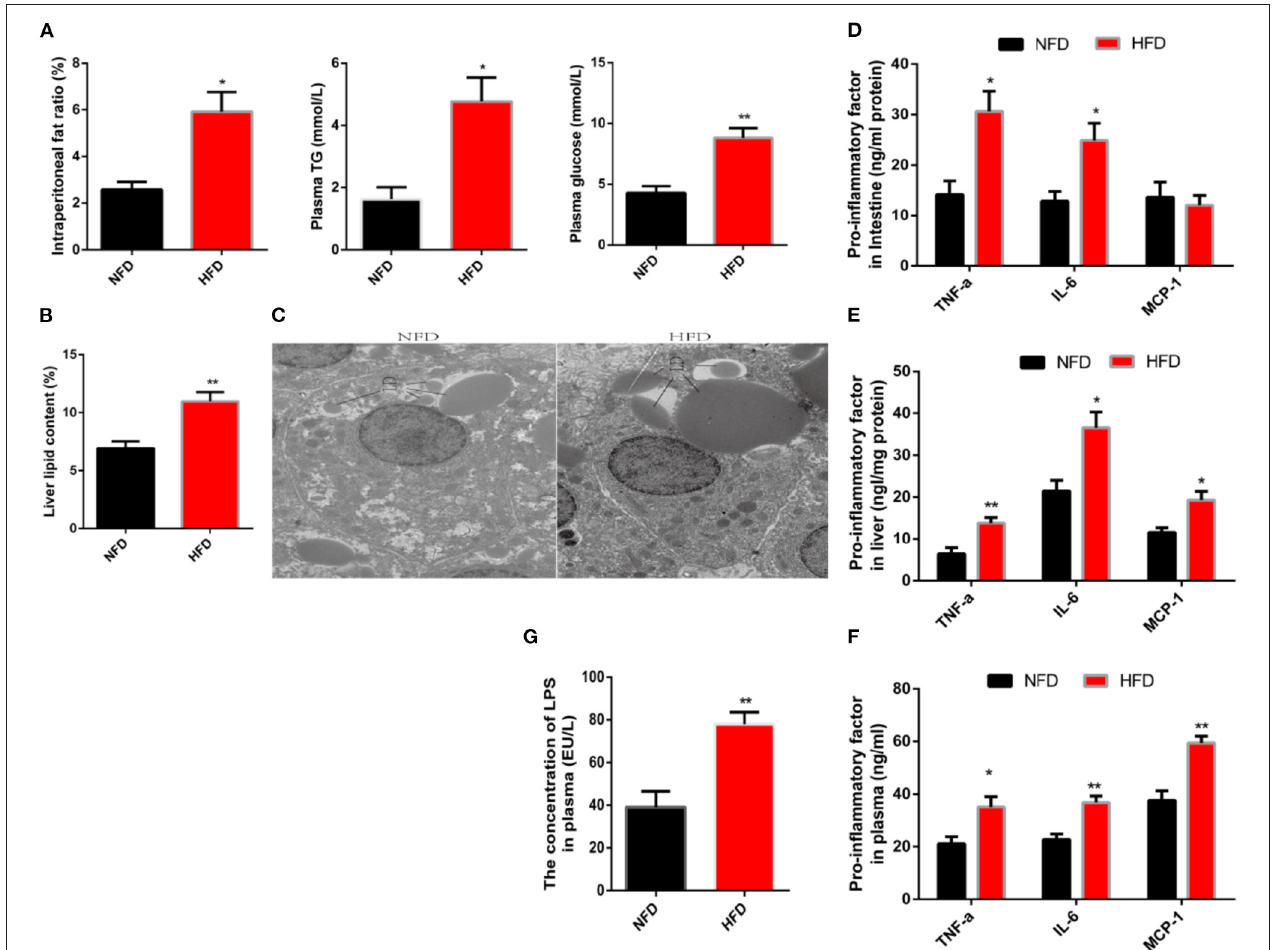
FIGURE 1 | Long-term consumption of a high-fat diet induces characteristics of obesity and low-grade systemic inflammation. Fish were fed a normal-fat diet (5% fat, NFD) or high-fat diet (10% fat, HFD) for 12 weeks. (A) Intraperitoneal fat ratio, plasma glucosep and plasma triglycerides (TG). (B) The content of liver fat. (C) Analysis of lipid droplets by transmission electron microscope. (D–F) The protein content of pro-inflammatory factors (TNF- α , IL-6 and MCP-1) in the intestine (D) , plasma (E) and liver (F) . (G) Concentration of LPS in plasma. Data are shown as mean ± SEM. N = 4. Two-tailed unpaired Student’s t -test was used. * P < 0.05, ** P <